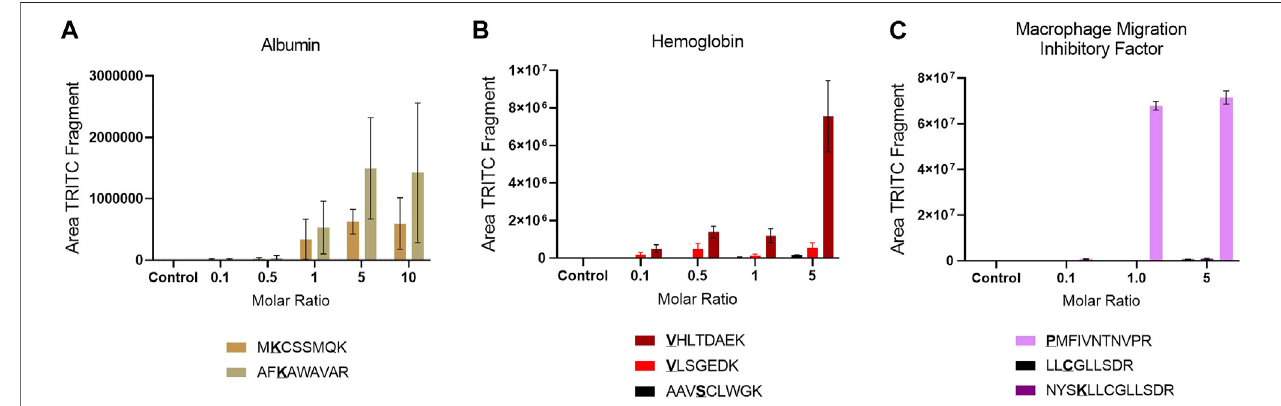
FIGURE2| SitereactivityrepresentedbytheareaoftheTRITCfragmentineachmodi fi edpeptideinthedifferentincubations, (A) Alb (B) Hb (C) MIF.Valuesarethe mean of three replicate analysis ± STD. * Underlined bold letters indicate the site of adduction.